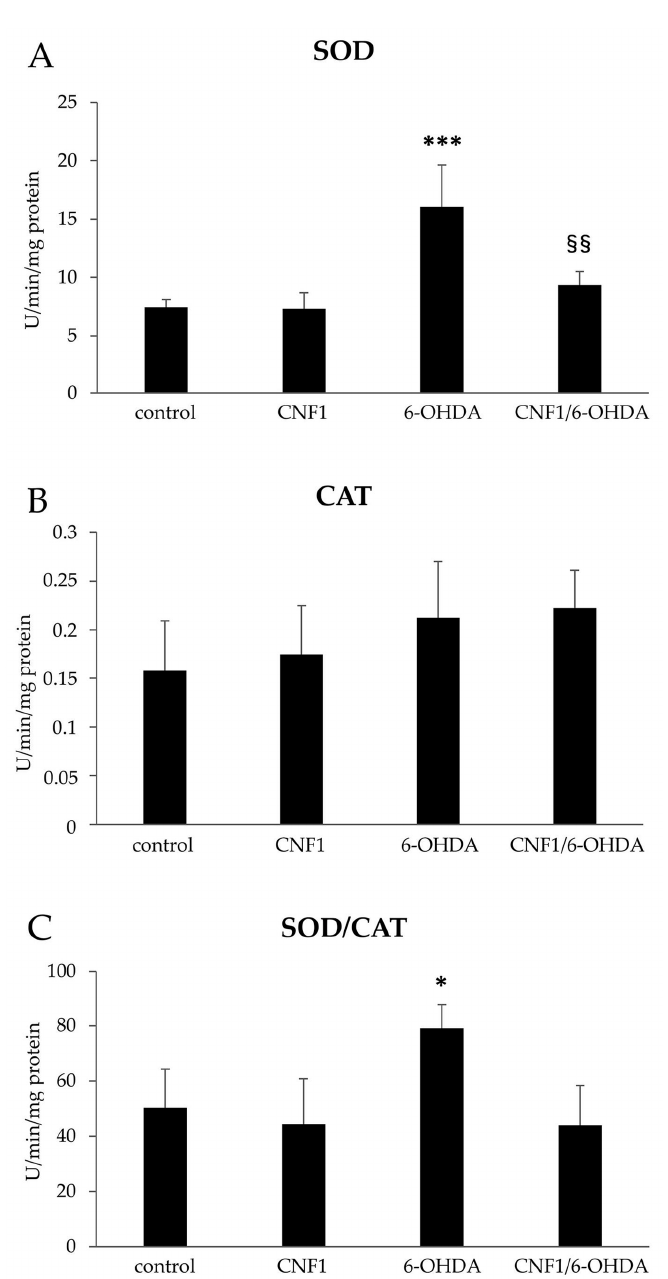
Figure 3. Evaluation of superoxide dismutase (SOD) and catalase (CAT) enzymatic activities in SH-SY5Y cells. ( A ) SOD activity; ( B ) CAT activity; ( C ) SOD / CAT ratio. The results are expressed as mean ± SEM from four independent experiments. *** p < 0.001 compared with control; §§ p < 0.01 compared with 6-OHDA; * p < 0.05 compared with